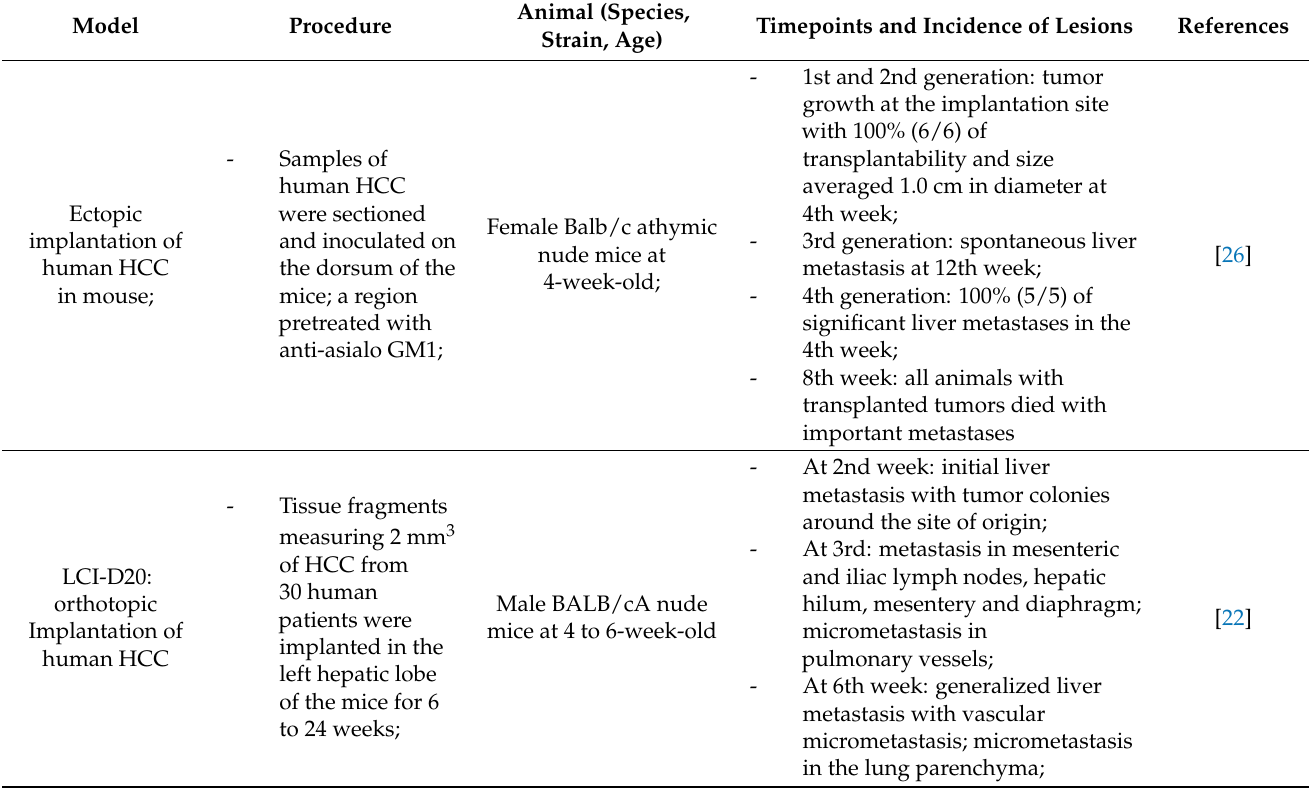
Table 1. Summary of some of the patient-derived xenograft HCC protocols in mice.